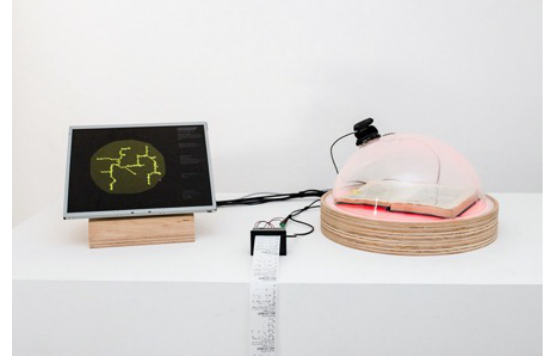
Figure 1 | Degenerative Cultures , Cesar & Lois Lumen Prize exhibition Uncommon Natures , Brighton, UK